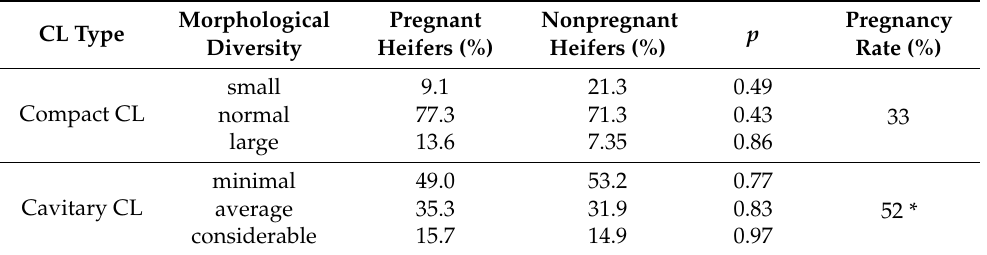
Table 8. Percentage of various morphological forms of the CL (6–8 days) after heat in pregnant and nonpregnant embryo-recipient heifers ( n = 300; * p <